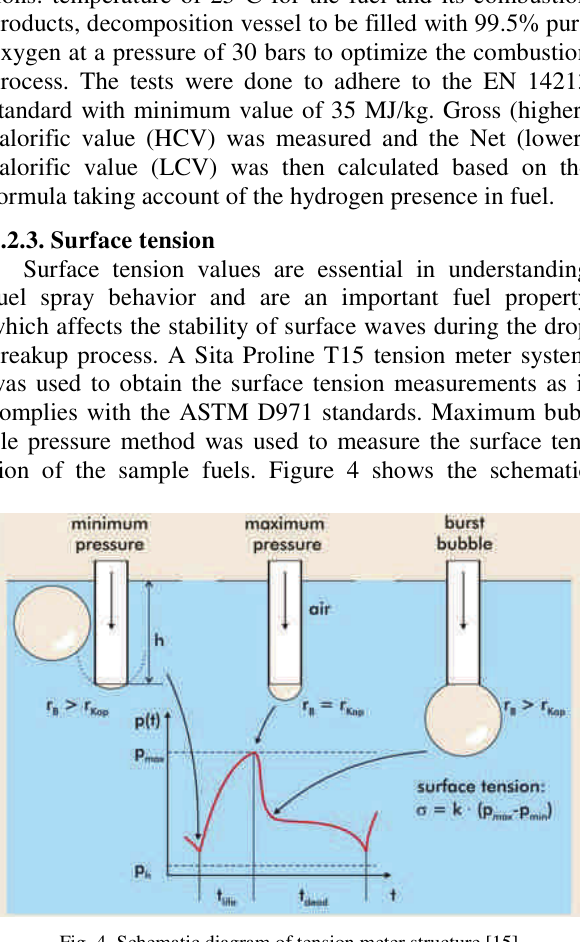
Fig. 4. Schematic diagram of tension meter structure